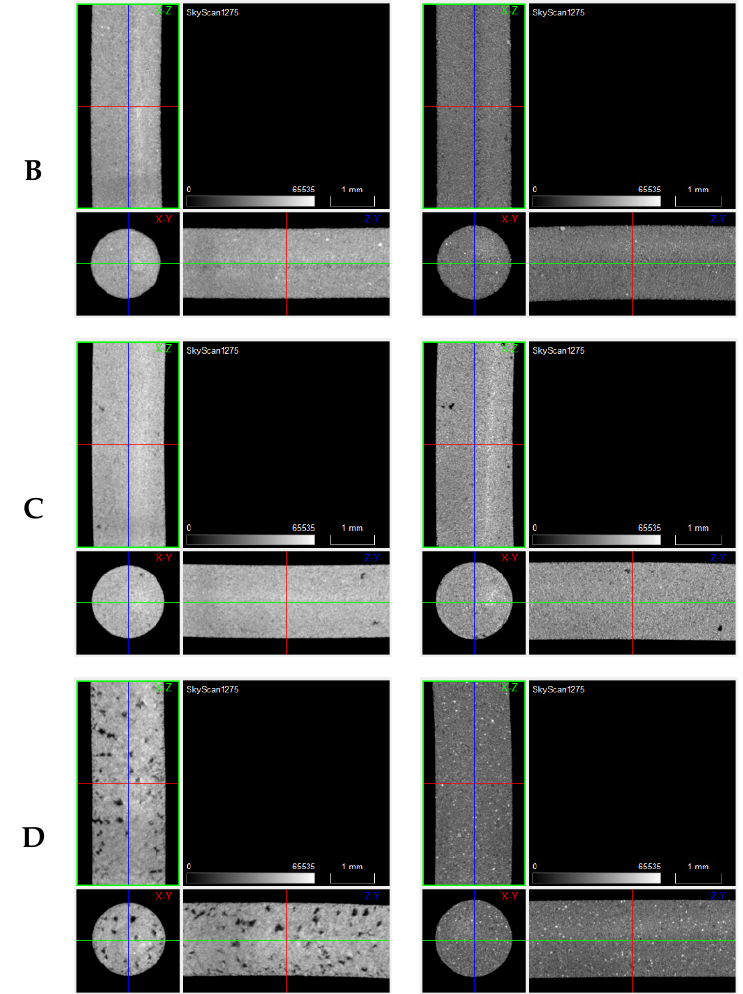
Figure 14. Tomographies of green vs. IP green filaments ( A – D ).